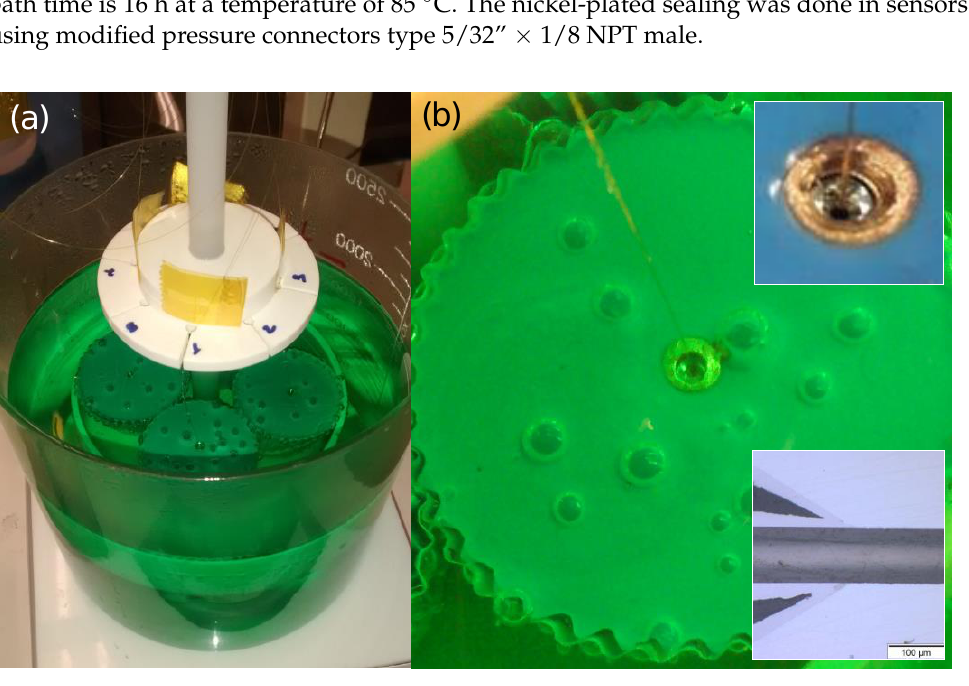
Figure 8. ( a ) Brazing sealing result in the internal part of the pressure connector and ( b ) the external part of pressure connector exhibiting the optical fiber.